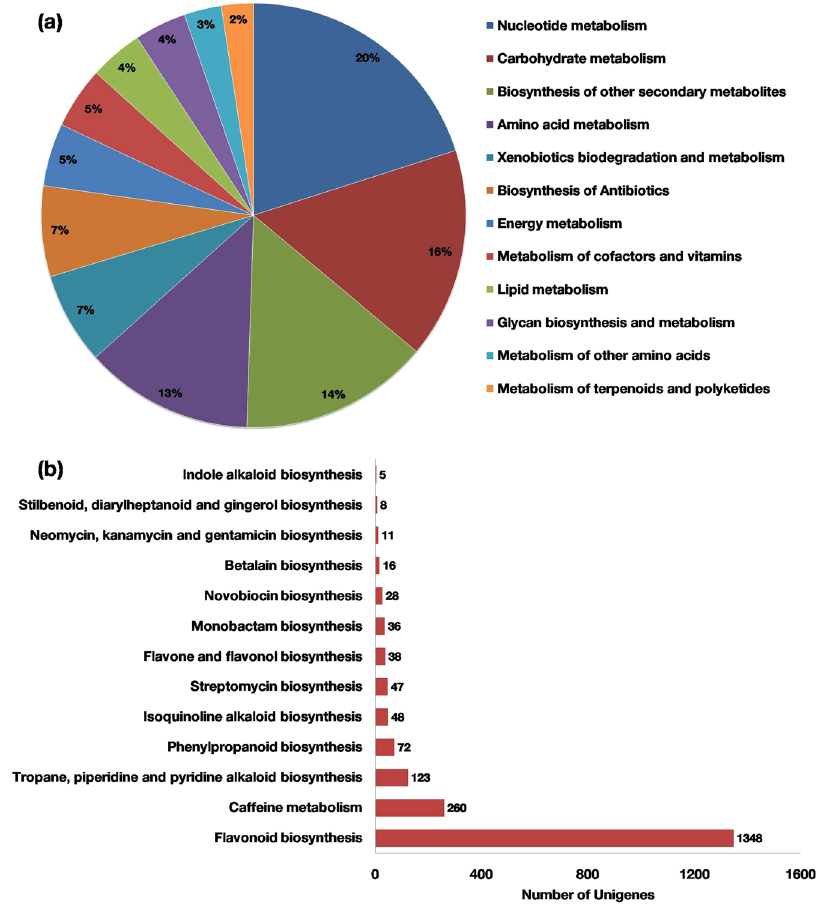
Figure 4. KEGG pathway unigene assignments. ( a ) Based on metabolic pathway. ( b ) Based on secondary metabolite